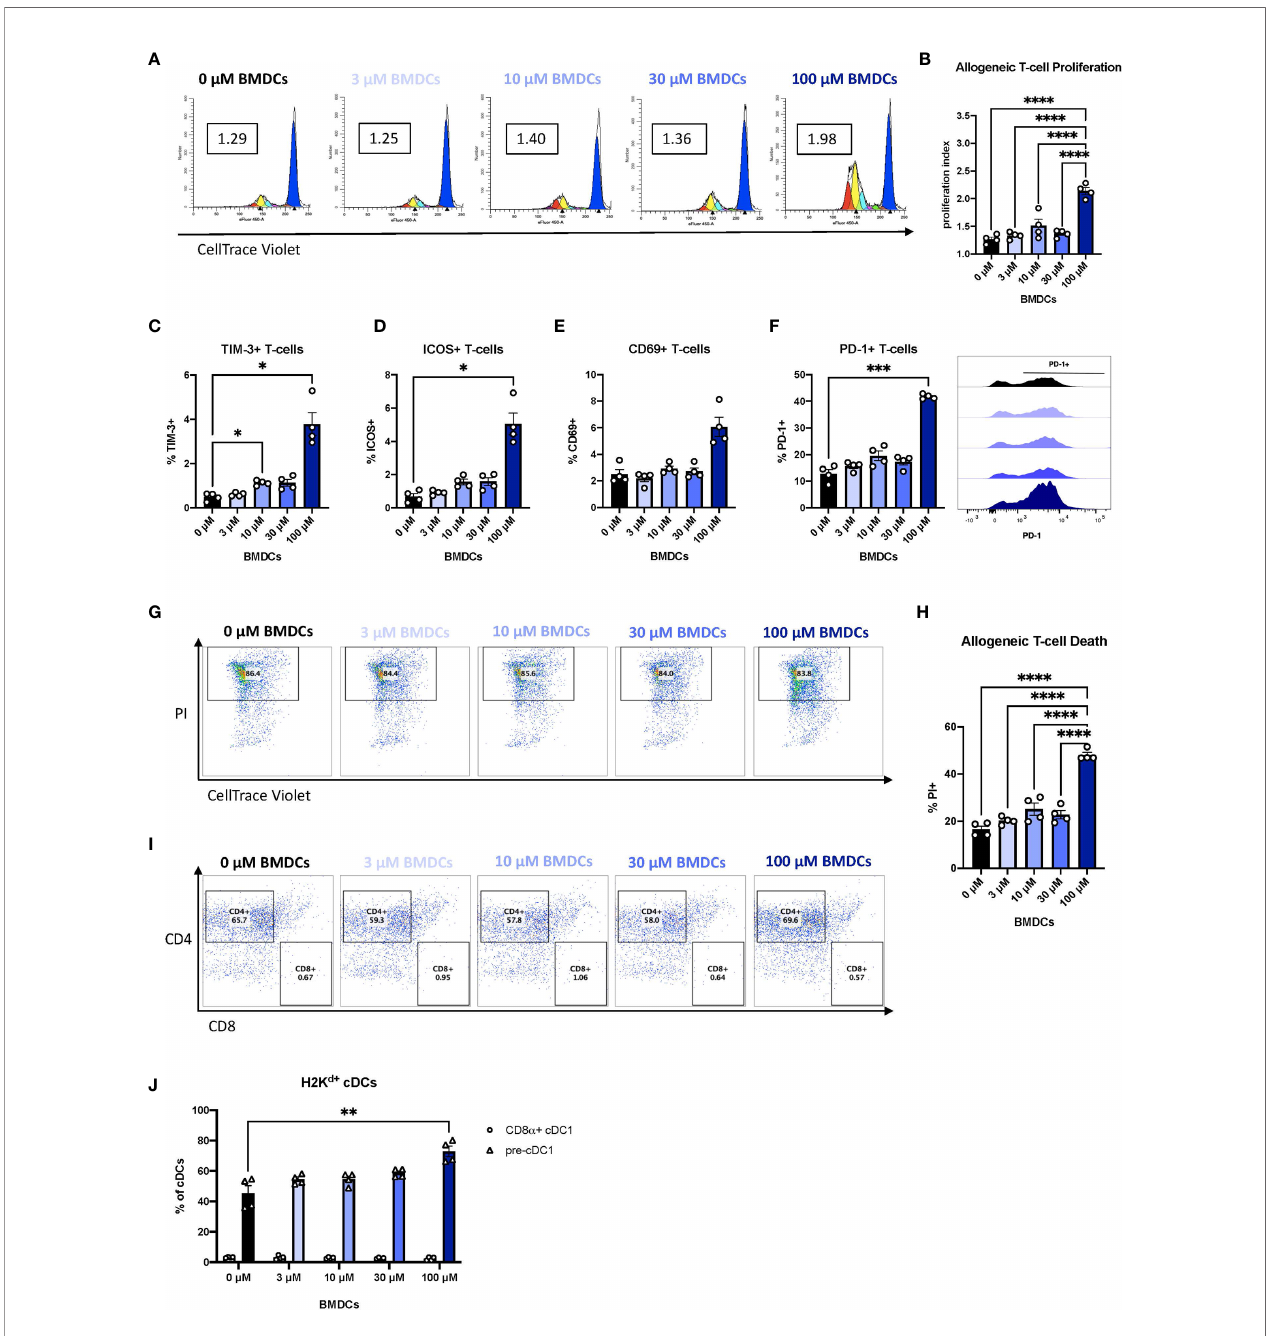
FIGURE 4 | Murine DCs exposed to BEN induce robust proliferation of alloreactive T-cells and expression of PD-1, followed by T-cell death. BALB/c FL-BMDCs were generated following brief exposure to BEN and co-cultured with C57BL/6 CellTrace-stained allogeneic T-cells at a ratio of 1:10. Data shown is representative of 2 independent experiments (n=4). (A) Representative histograms generated by ModFit software to quantify T-cell proliferation on day 3 as a proliferation index (PI) (boxed value) in response to stimulation with FL-BMDCs exposed to the indicated concentration of BEN (Gated on H2K b+ to exclude DCs from analysis). (B) Mean proliferation index on day 3 of co-culture shown with SEM. (C – E) Mean percent expression of (C) TIM-3, (D) ICOS (CD278), and (E) CD69 on H2K b+ allogeneic T-cells on day 3 shown with SEM. (F) Mean percent expression of PD-1 on H2K b+ allogeneic T-cells on day 3 shown with SEM, and representative histograms (right). (G) Representative fl ow cytometry plots indicating the percent of dead (PI + ) T-cells within the proliferative fraction (Gated on H2K b+ CellTrace low ). (H) Allogeneic T-cell death on day 4 of the assay shown as mean percent of all allogeneic T-cells in culture with SEM. One-way ANOVA and Dunnett ’ s multiple comparisons test were used to determine signi fi cance among groups. (I) Representative fl ow cytometry plots indicating the percentages of CD4 + and CD8 + T-cells among dead allogeneic T-cells on day 4 (Gated on H2K b+ CellTrace low PI + ). (J) Mean percent of CD8 a + cDC1s (circles) and pre-cDC1s (triangles) among H2K d+ CD11c + B220 - FL-BMDCs in co-culture with allogeneic T-cells on day 3 shown with SEM. Two-way ANOVA and S ̌ ida ́ k ’ s multiple comparisons test were used to determine signi fi cance among groups. *P < 0.05, **P < 0.01, ***P < 0.001, ****P <